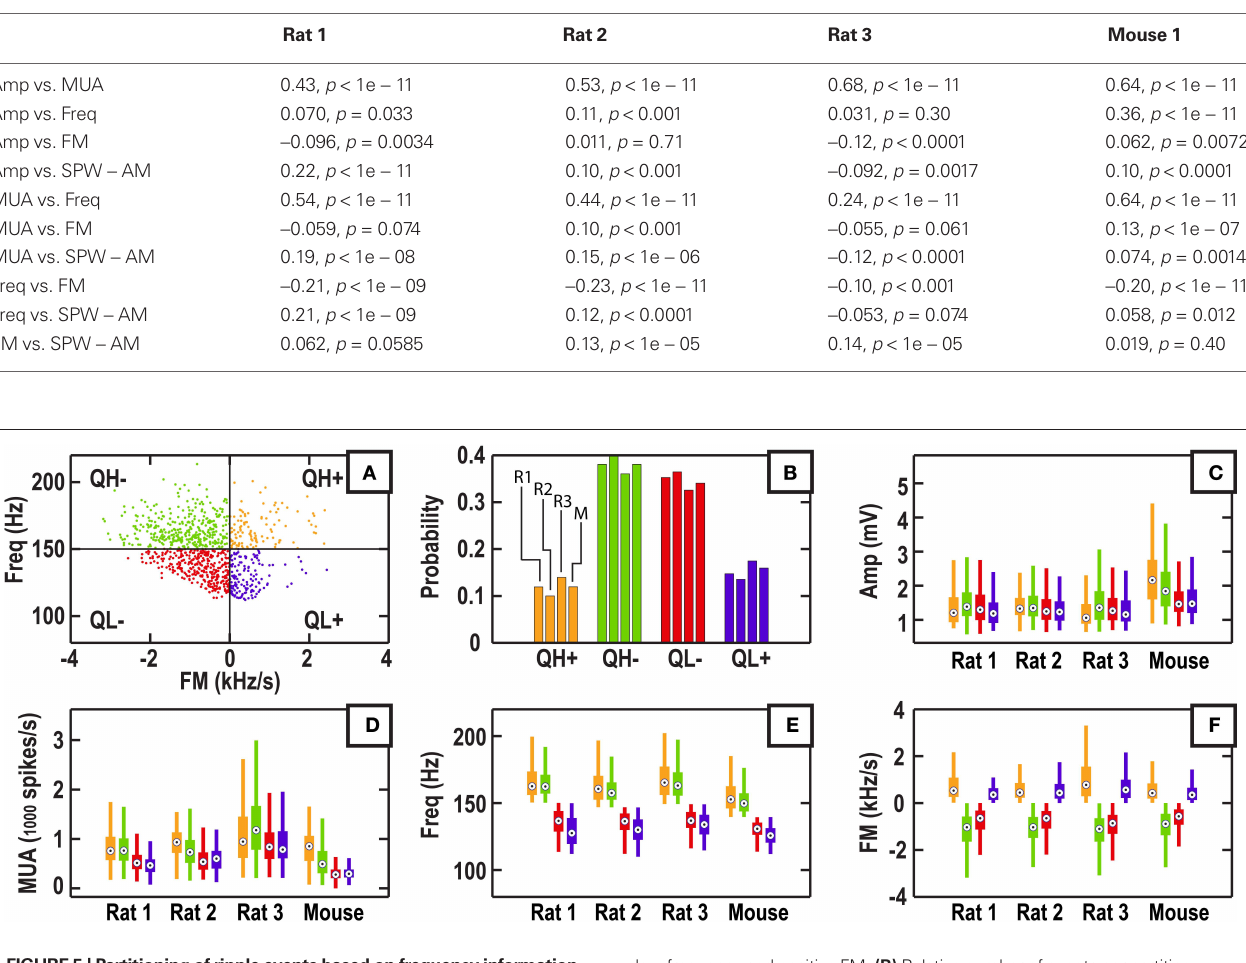
low frequency and positive FM. (B) Relative number of events per partition quadrant for three rat subjects and one mouse subject. (C–F) Standard box-and- whisker plots (95% CI) for features of each partition and each data set. Plots are grouped by subject rather than